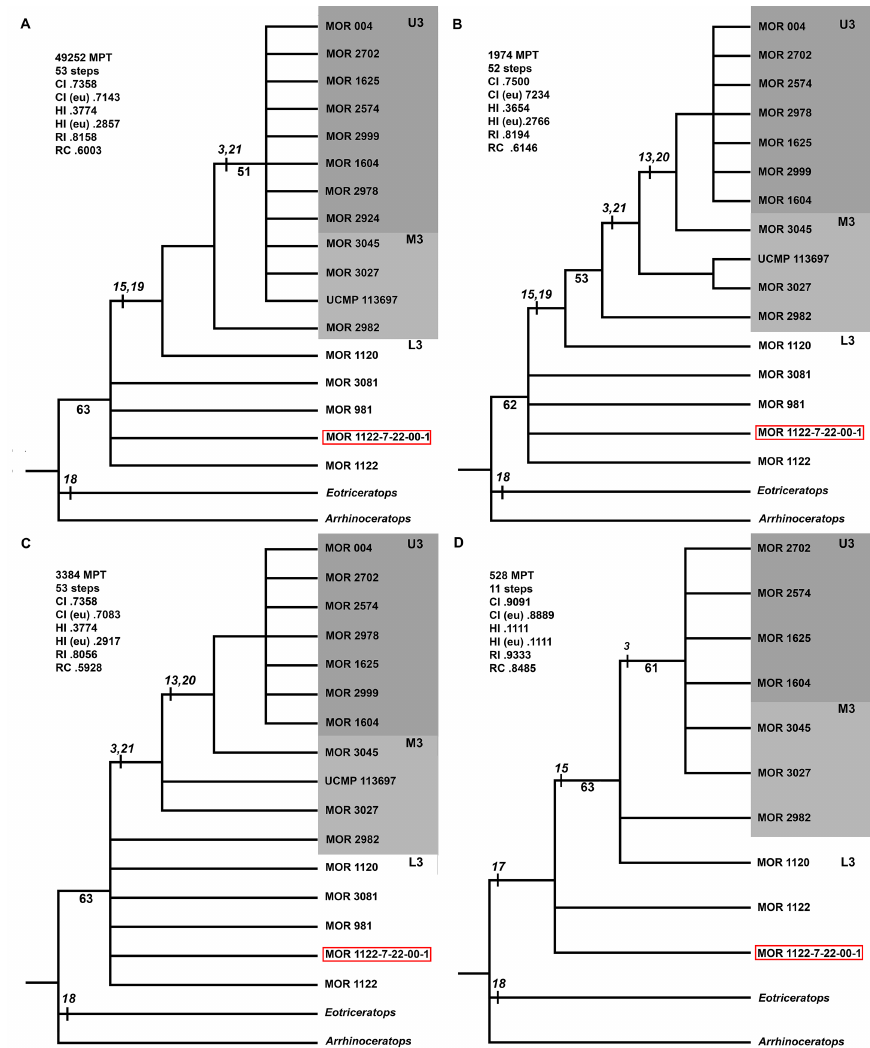
Figure 12. Results of cladistic analyses incorporating MOR 1122 7-22-00-1 into the dataset of Scannella et al. (2014). A) Strict consensus tree excluding specimens from Scannella et al. 2014 that cannot be coded for at least 10 characters or characters of the frill. MOR 1122 7-22-00-1 groups with specimens exhibiting the ‘ Torosaurus ’ morphology. B) Strict consensus tree after removal of MOR 2924. When the positioning of the ventromedial foramina in MOR 981 is coded as ‘?’ MOR 1122 7-22-00-1 groups with specimens exhibiting the ‘ Torosaurus ’ morphology. C) When coding of the ventromedial foramina of MOR 981 is changed to indicate that they are not closely positioned, as suggested by Farke (2007), specimens from L3 are recovered in a polytomy in the strict consensus tree. D) Strict consensus tree when only characters of the premaxilla are included in the analysis and specimens which cannot be coded for at least three characters are removed. Bootstrap support values are presented below nodes. Unambiguously optimized synapomorphies (0=>1) present at strict consensus tree internodes are above nodes (numbers correspond to characters in Appendix 1). Stratigraphic positions of MOR 981, MOR 1604, and MOR 2978 are undetermined (Scannella et al. 2014). Abbreviations: MPT, most parsimonious trees; CI, consistency index; HI, homoplasy index; RI, retention index; RC, rescaled consistency index; eu; excluding uninformative